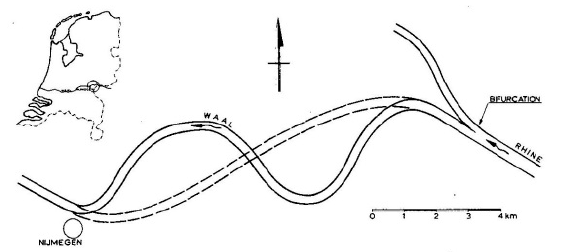
Figure 11. Proposed bend cutoffs in the Upper Waal.